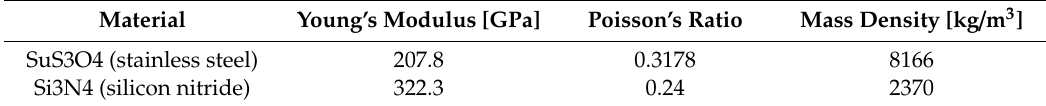
Table 1. Material properties of the FG nano-beam (silicon nitride-stainless steel).